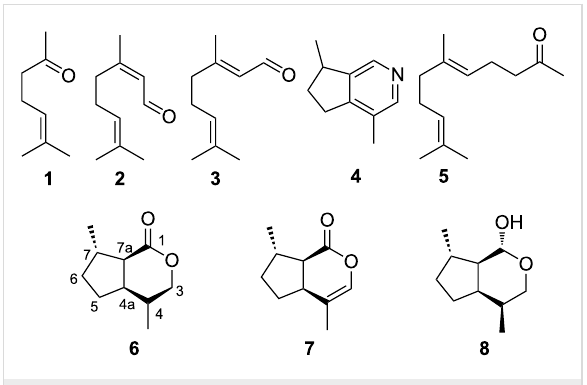
Dihydronepetalactones are derivatives of nepetalactone ( 7